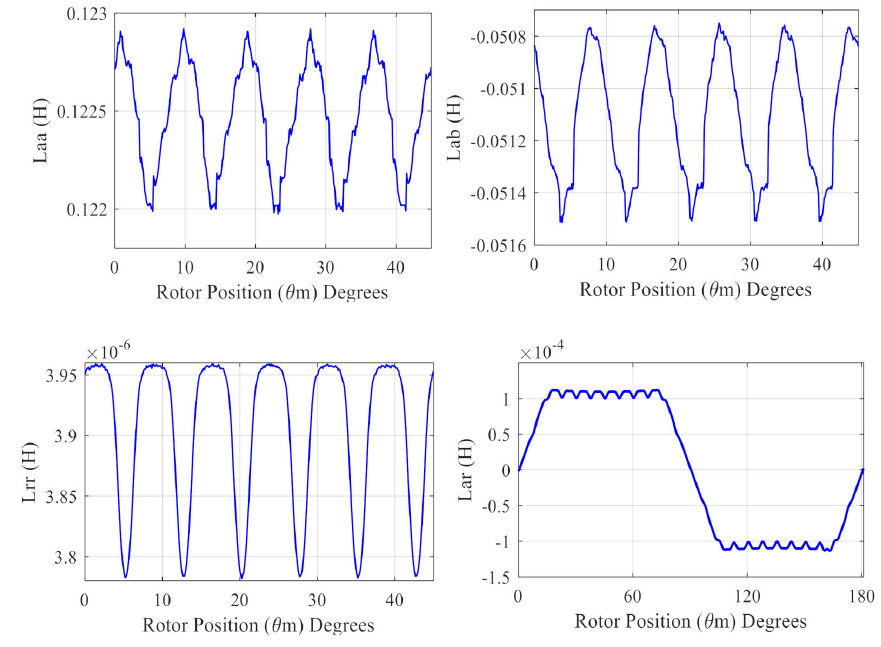
Figure 6. The calculated inductances as a function of the rotor position.